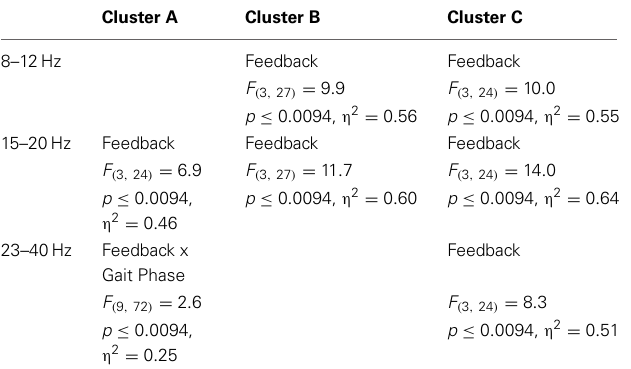
Table 2 | ANOVA results: significant main and interaction effects. FIGURE 4 | Average gait event-related spectral perturbations